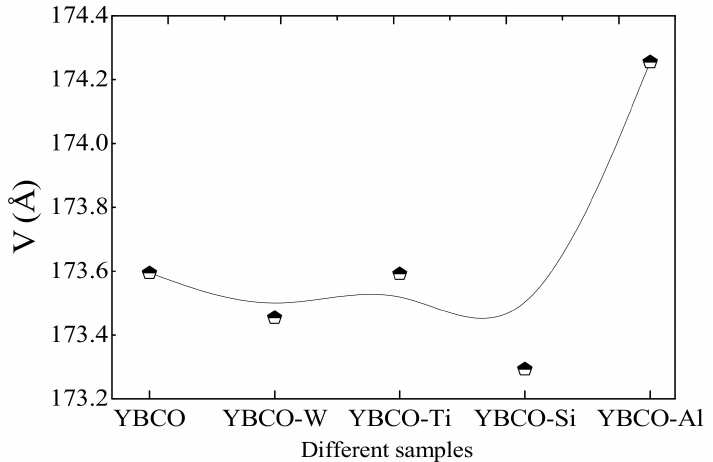
Figure 4. Variations of the lattice unit cell volume ‘V’ with different